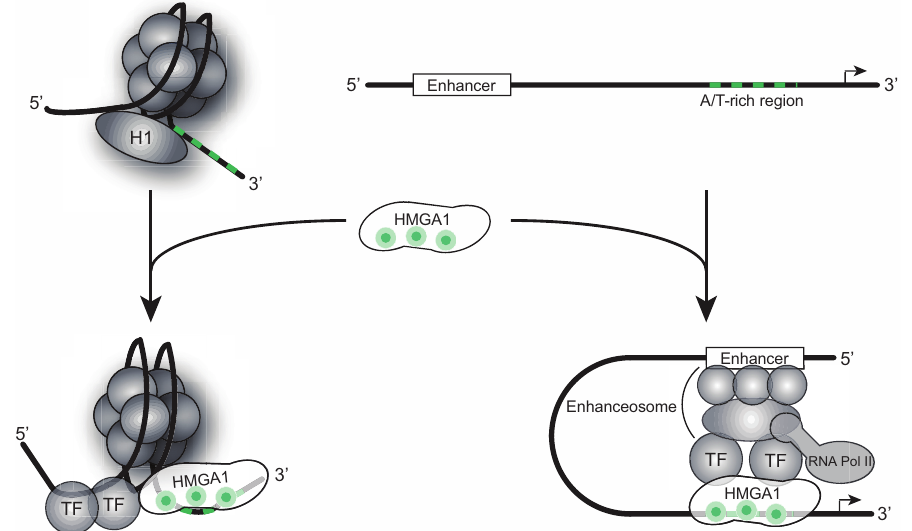
Figure 1. Chromatin- and gene expression regulation by HMGA1. HMGA1 binds to A/T-rich DNA sequences in gene promoter and enhancer regions. It acts as an antagonist of the linker histone H1, resulting in an open chromatin structure, permissive for gene transcription. Interacting with different transcription factors, HMGA1 is involved in enhanceosome formation, that way regulating gene-specific